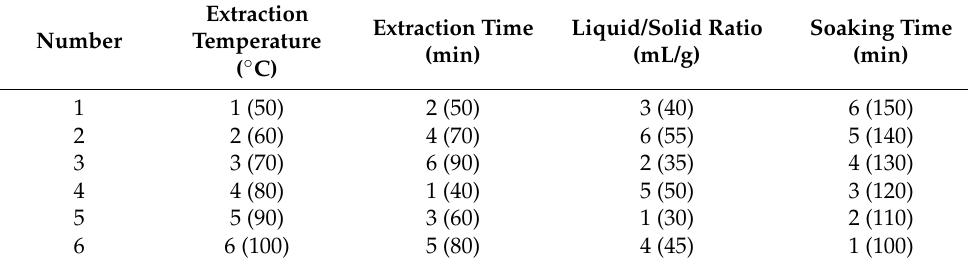
Table 8. The levels of variables employed in the uniform